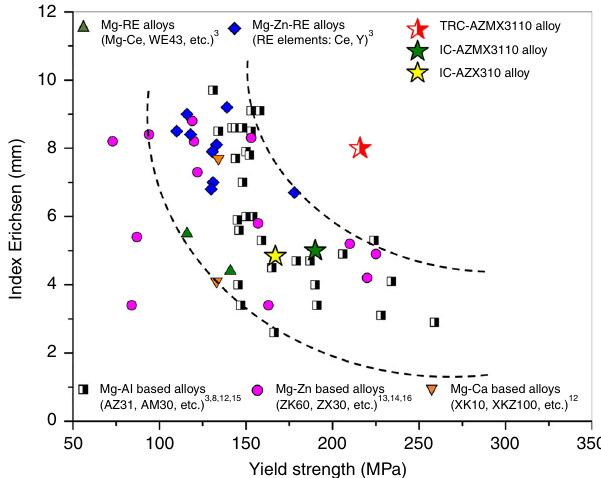
Fig. 1 Yield strength and stretch formability represented by the Index Erichsen (IE) value at room temperature of various Mg alloys